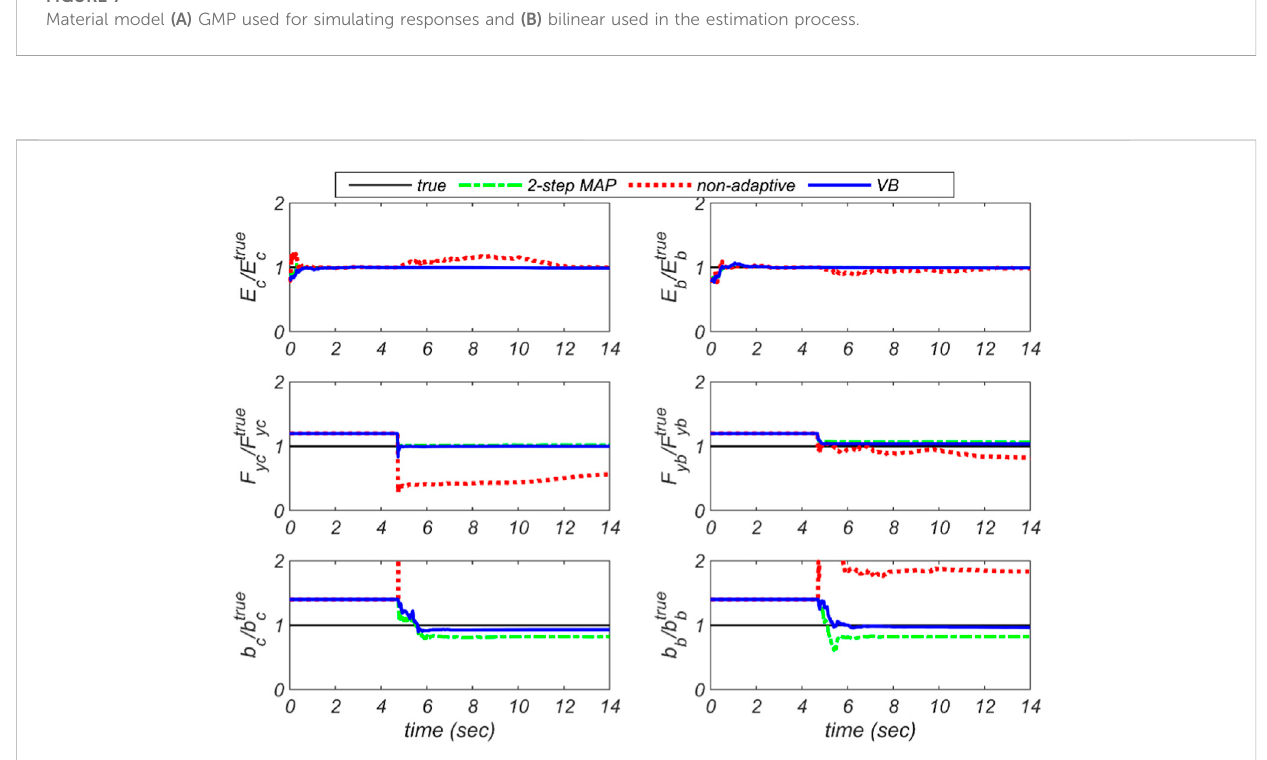
FIGURE 8 Time histories of the estimated model parameters obtained by the three methods: the proposed VB method, two-step marginal MAP estimation method, and the non-adaptive Bayesian method for the second case study.